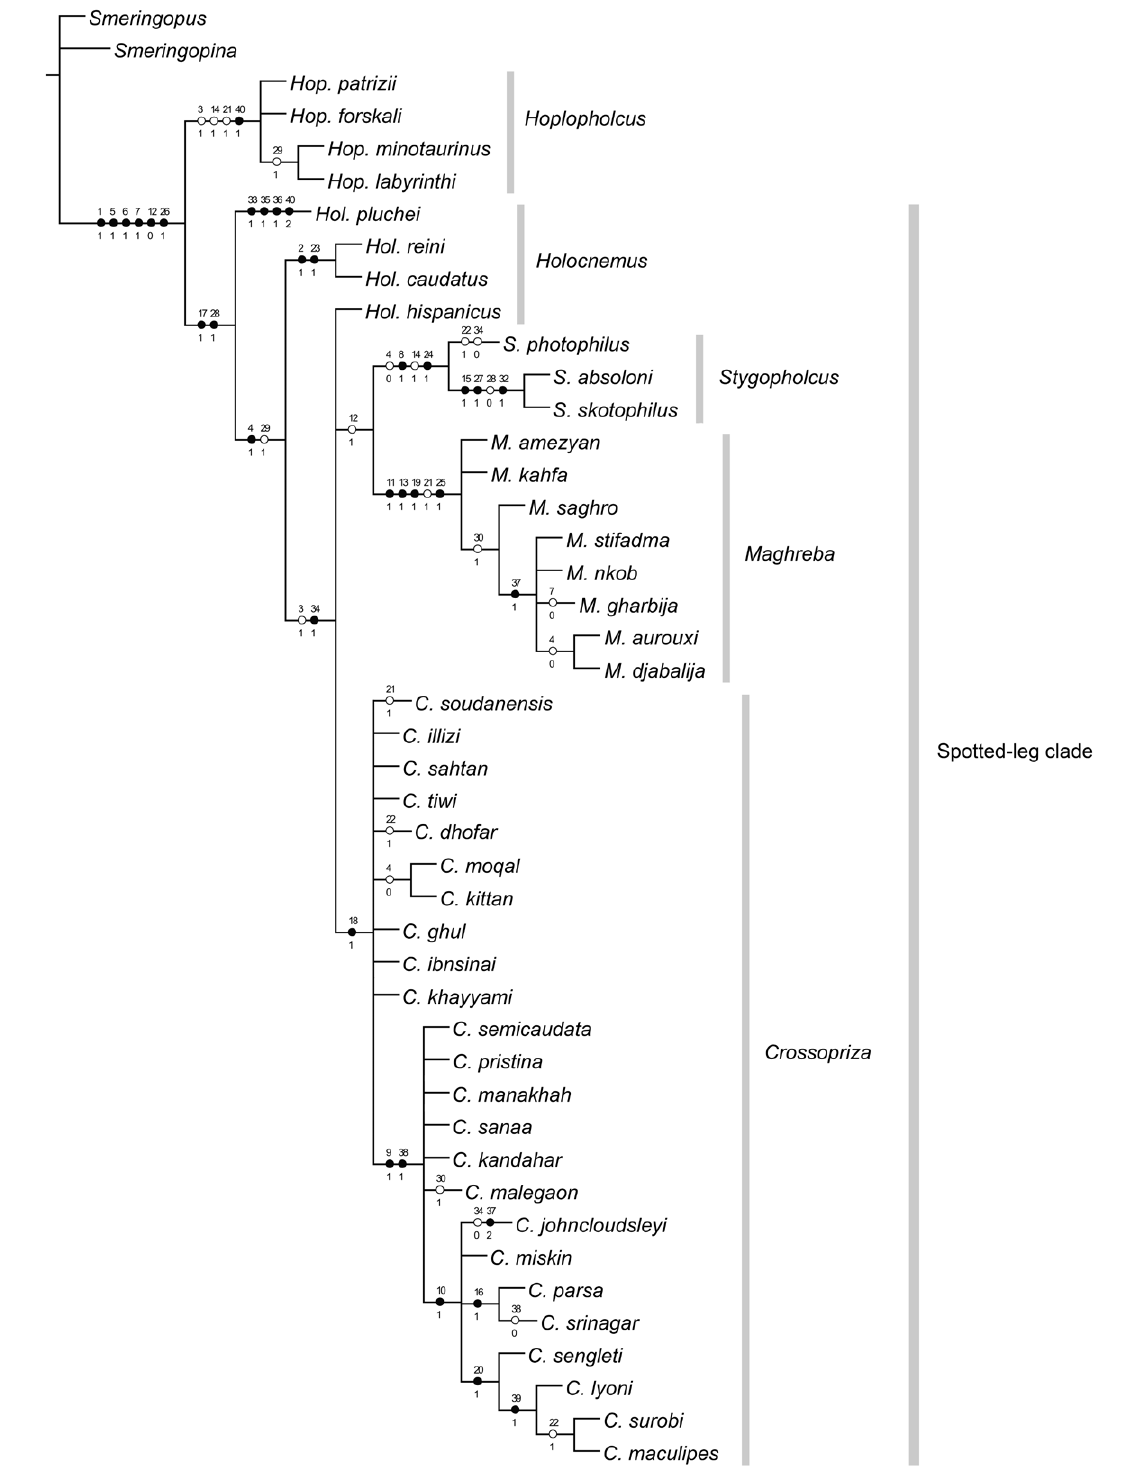
Fig. 1. Single most parsimonious cladogram of the spotted-leg clade resulting from analyses of the matrix in Appendix 1 using equal character weights and successive character weighting. Only unambigous character changes are shown. See Appendix 3 for differences in analyses using implied character weighting with conc =1 and